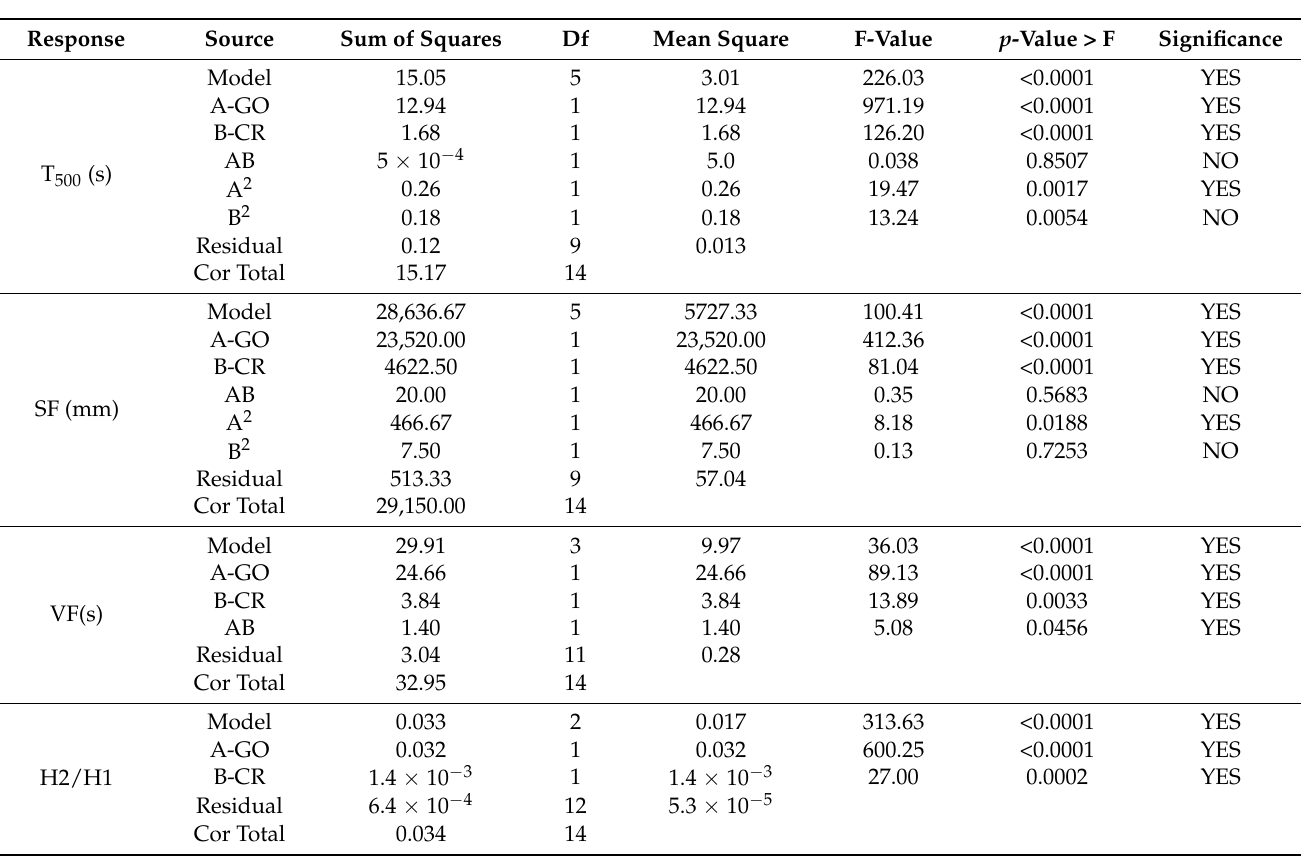
Table 2. Summary of ANOVA.